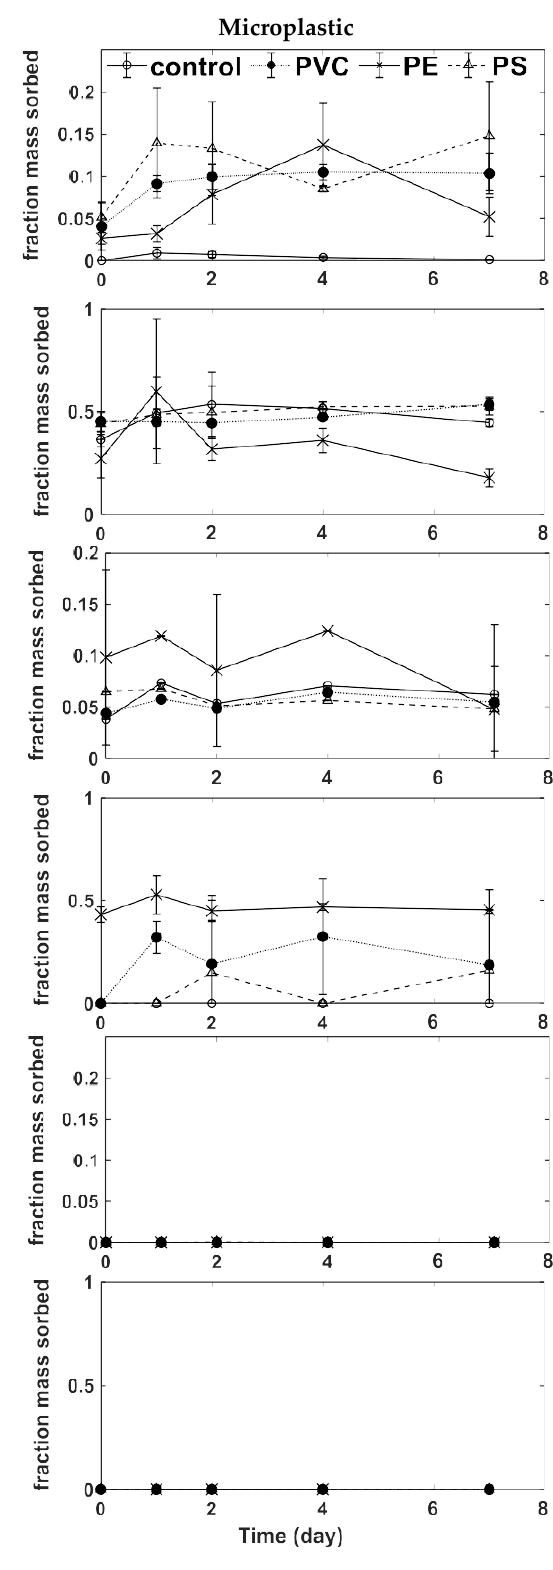
Figure 1. Fraction of each CEC sorbed onto macro- and microplastics over the period of 7 days where solid line with ○ is the control, dotted line with ● is PVC, solid line with × is PE, and dashed line with △ is PS. Both DFC (log K ow 4.51) and ACE (log K ow 0.46) were consistently retained by the plastics despite very different hydrophobicities. Adsorption of CECs (both the number of CECs ad- sorbed and the CEC mass fraction adsorbed) also could not be predicted by the size of the plastics.